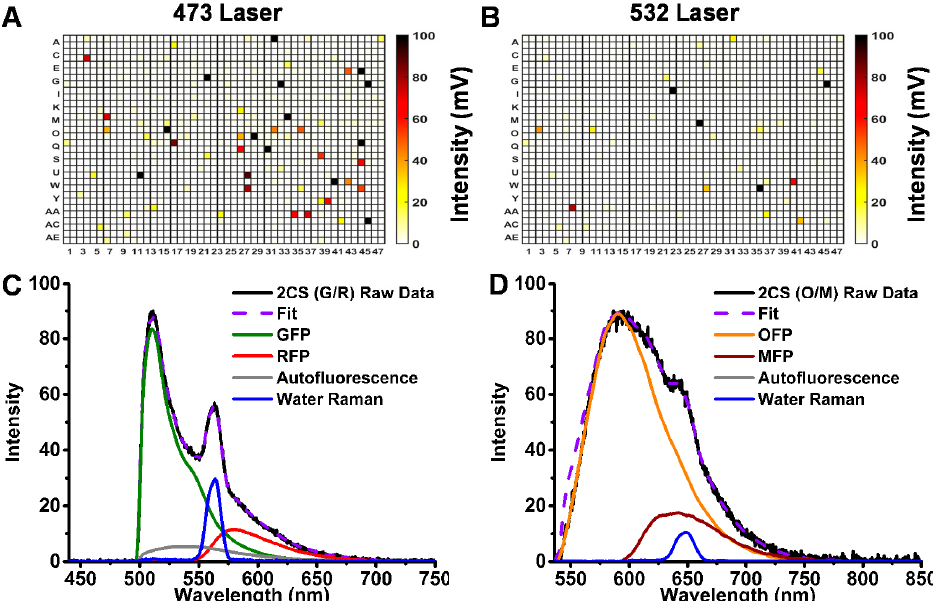
Figure 2. Intrinsic fluorescence interference of the Library of Pharmacologically Active Compounds (LOPAC) small-molecule library assessed in 1536-well-plate format by ( A ) 473-nm microchip laser excitation and ( B ) 532-nm laser excitation. Spectral recording analysis of stable cell line expressing ( C ) 2CS (GFP/RFP) with 473-nm excitation and ( D ) 2CS (OFP/MFP) with 532-nm excitation.